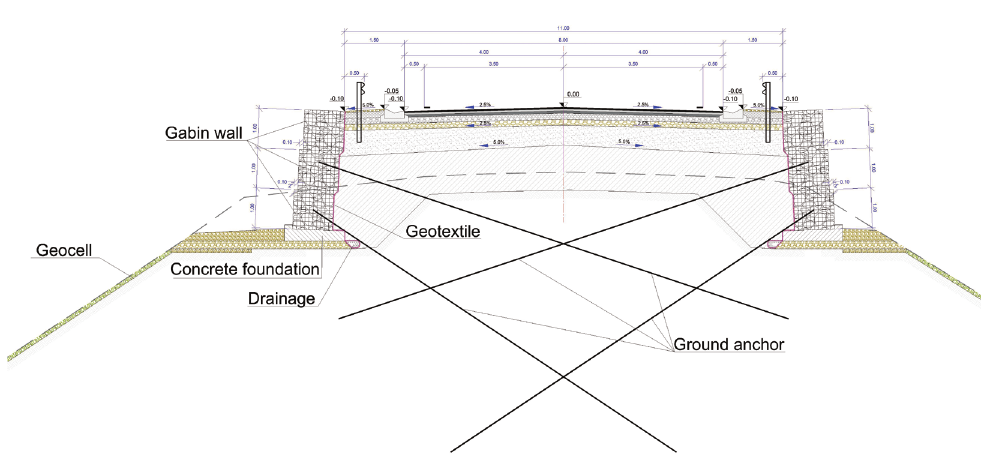
Figure 5. Project solution for national motorway